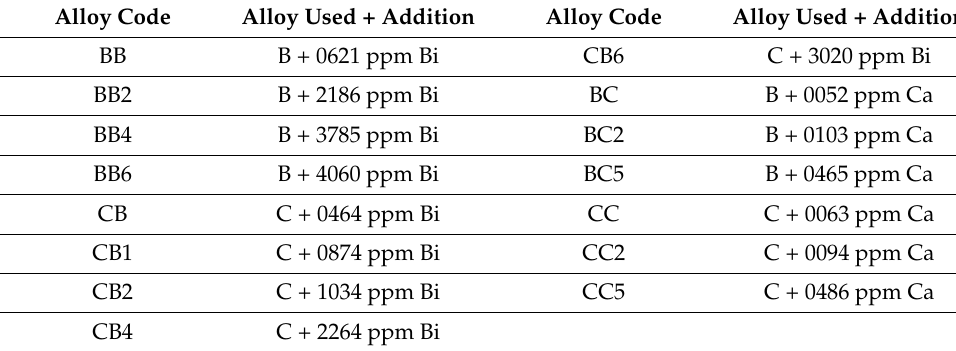
Table 2. Alloy codes for Bi- and Ca-containing alloys. Alloy Code Alloy Used + Addition Alloy